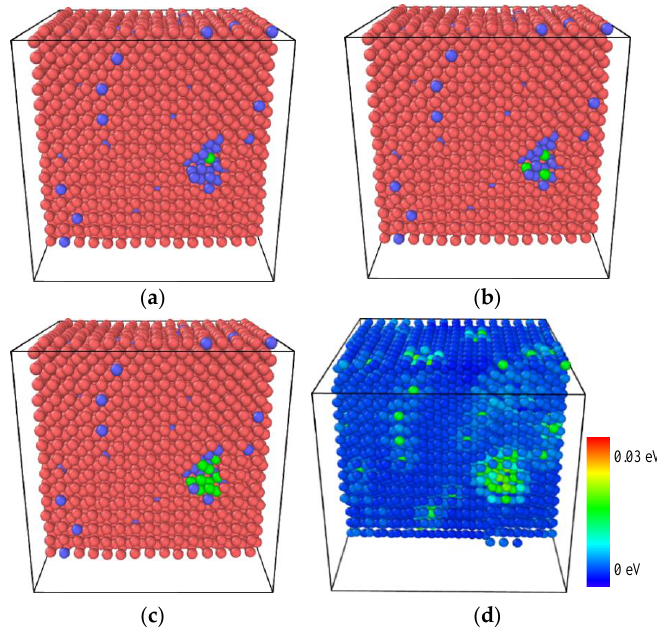
Figure 11. The internal defect evolution and atomic energy distribution in the aged Fe-3.5Cu-0.1V alloy during the tensile process, ( a – c ) respectively show the vacancy distribution at 31% 5 strain, 32.5% strain and 34% strain. ( d ) When the strain is 34%, the atoms are colored according to the atomic energy, Red for Fe atoms; blue for Cu atoms; green for vacancies.